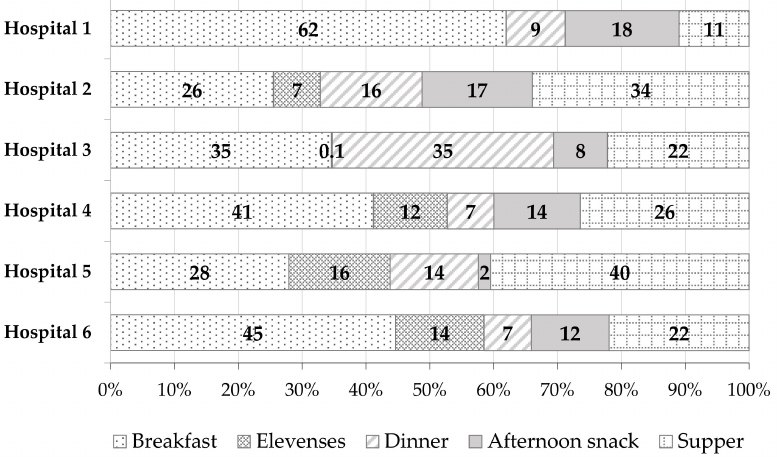
Figure 2. The percentage share (%) of trans fatty acids (TFAs) from different meals in the total TFAs content derived from the whole-day hospital diet.